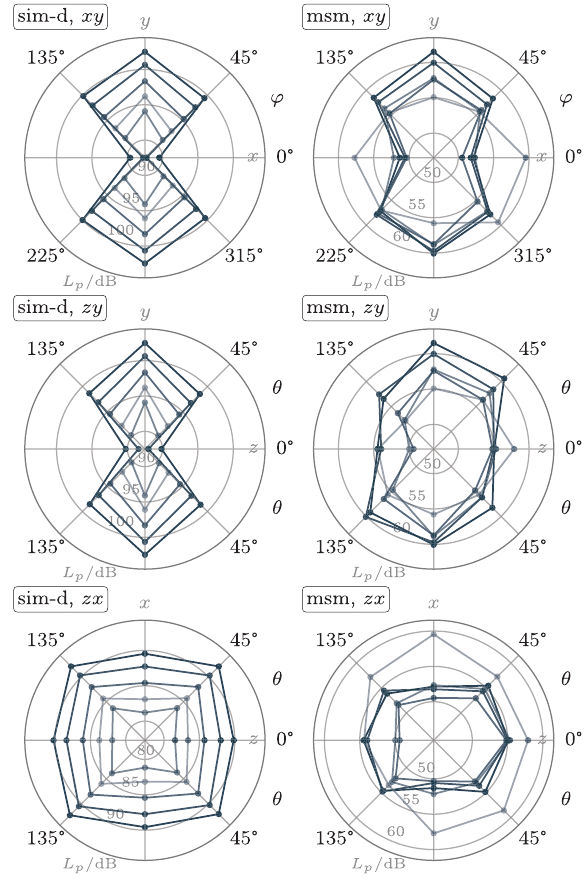
Figure 16. ES 18 directivity patterns in different planes for the simulated dipole and the measured drone for octave bands from 500 Hz to 8 kHz (shades from light to dark). Displayed dynamic is 15 dB below